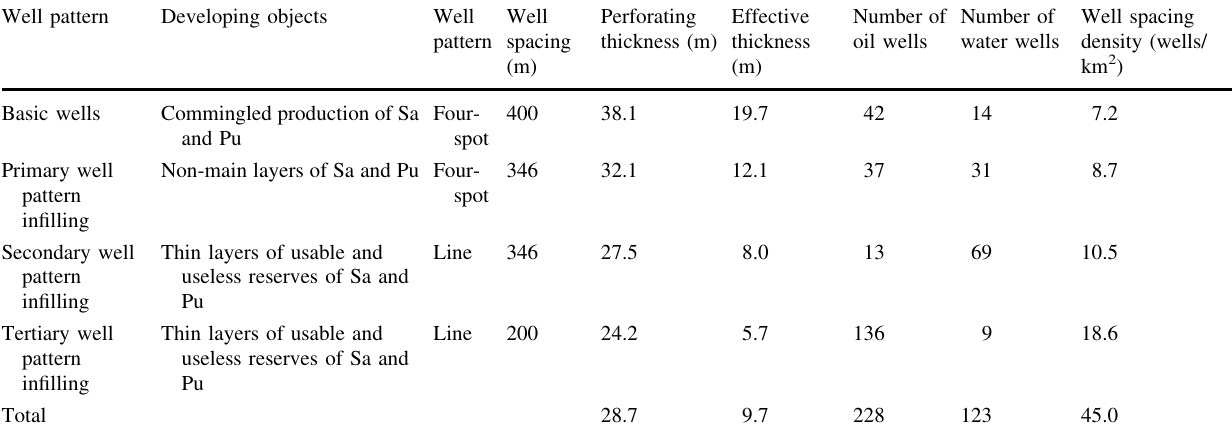
Table 1 Summary sheet of well pattern deployment for target